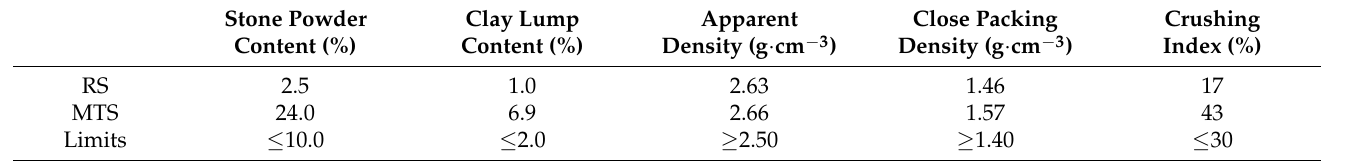
Table 3. Physical performance indexes of RS and